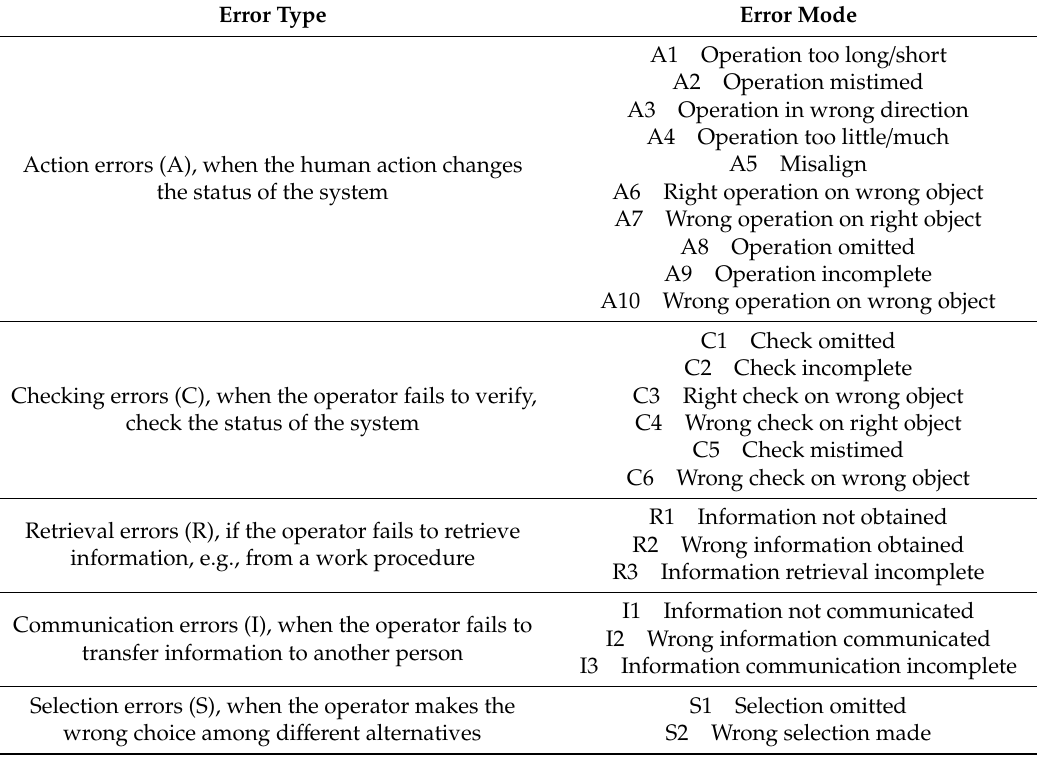
Table 1. Systematic human error reduction and prediction approach (SHERPA) error types and modes (adapted from